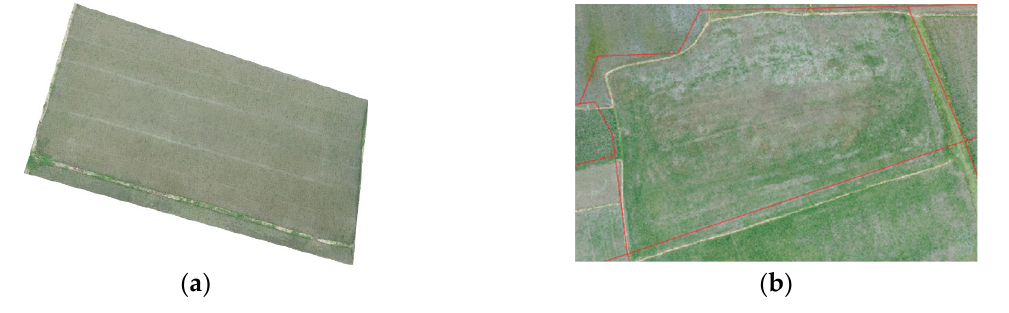
Figure 5. A field block cut from the original image with the help of vector data. ( a ) The matched block cut from the image with the help of the vector; ( b ) the field block that acquires an offset to the image because of the shape change that occurred in different years.